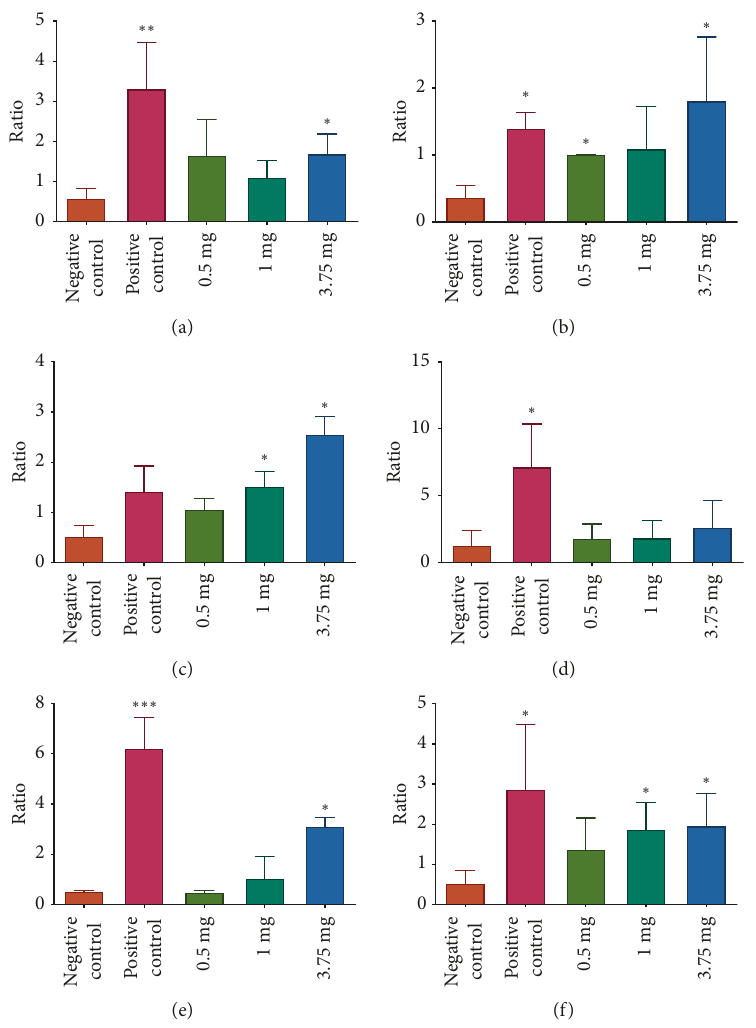
Figure 3: Cytokine production by C57BL/6 mice exposed to Pichincha’s volcanic ash: production of the inflammatory markers (a) NRLP 3, (b) caspase I, (c) pro-IL-1, (d) IL-1 β , (e) IL-6, and (f) IL-8 at 7 days after treatment with 0.5, 1, and 3.75mg/100g body